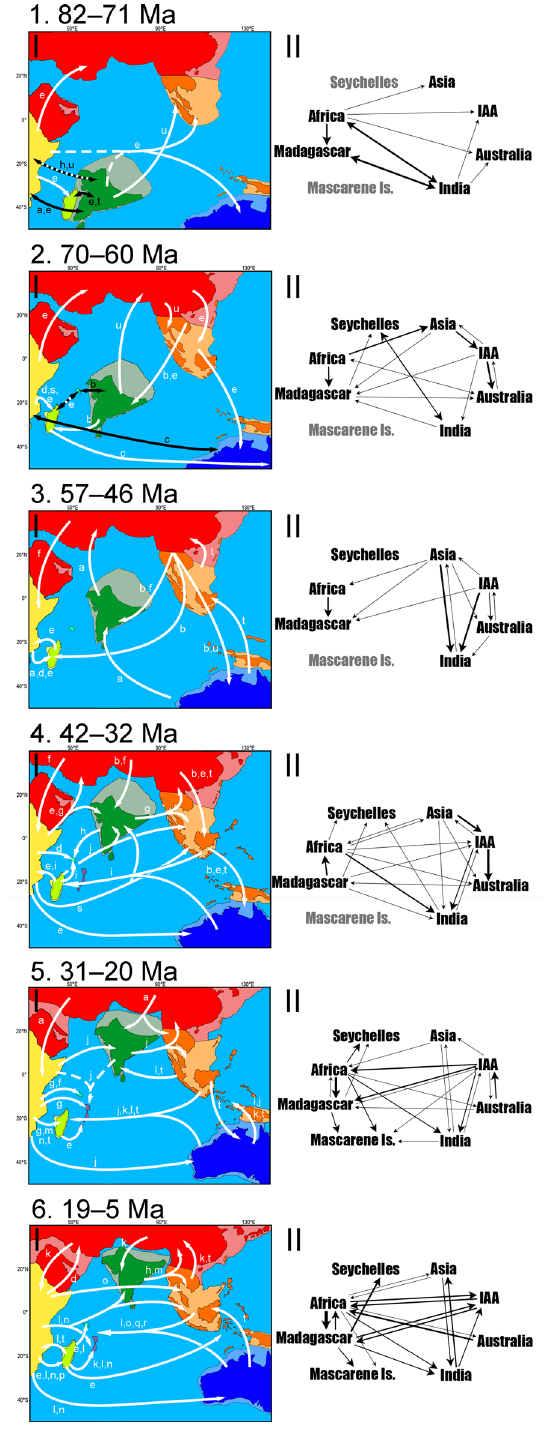
Figure 2. Dated results from BayArea and DEC at ~ 80 Ma (1), ~ 66 Ma (2), ~ 55 Ma (3), ~ 40 Ma (4), ~ 25 Ma (5), and ~ 15 Ma (6). (I) Mapped colonisation routes by taxon. Represented Biogeographic regions are colour-coded: Africa in yellow, Asia in red, Australia in blue, IAA in orange, India in green, Madagascar in light green, MI in purple and Seychelles in cyan (lighter colours represent continental shelves). Taxa represented are Boidae ( a ), Neobatrachia ( b ), Palaeognathae ( c ), Chamaleoninae ( d ), Gekkonidae ( e ), Natricinae ( f ), Testudinidae ( g ), Caecilia ( h ), Emballonuridae ( i ), Ficus ( j ), Psittacoidea ( k ), Atyidae ( l ), Exacum ( m ), Rubiaceae ( n ), Pteropodidae ( o ), Acrocephalidae ( p ), Anatini ( q ), Aphananthe ( r ), Strepsirrhini ( s ), Loranthaceae ( t ), and Typhlopoidea ( u ). White arrows represent dispersal and black arrows represent vicariance. Dashed arrows represent competing ancestral areas that may have composed an entire ancestral range. Note that the white and black arrow in (1) represents the uncertainty between vicariance and dispersal due to the confidence interval of the nodal dates. The map only illustrates relative positions and does not show the precise size and shapes of the continents. Based on refs. 1,5,8 . (II) Total weighted colonisation routes. One-headed arrows represent dispersal and two-headed arrows represent vicariance. Line thickness corresponds to the number of colonisations. Regions with their names in grey were not present at the given timeframe. The arrows do not have any specific order inside each represented timeframe. For specific dates or taxa, please refer to Appendix